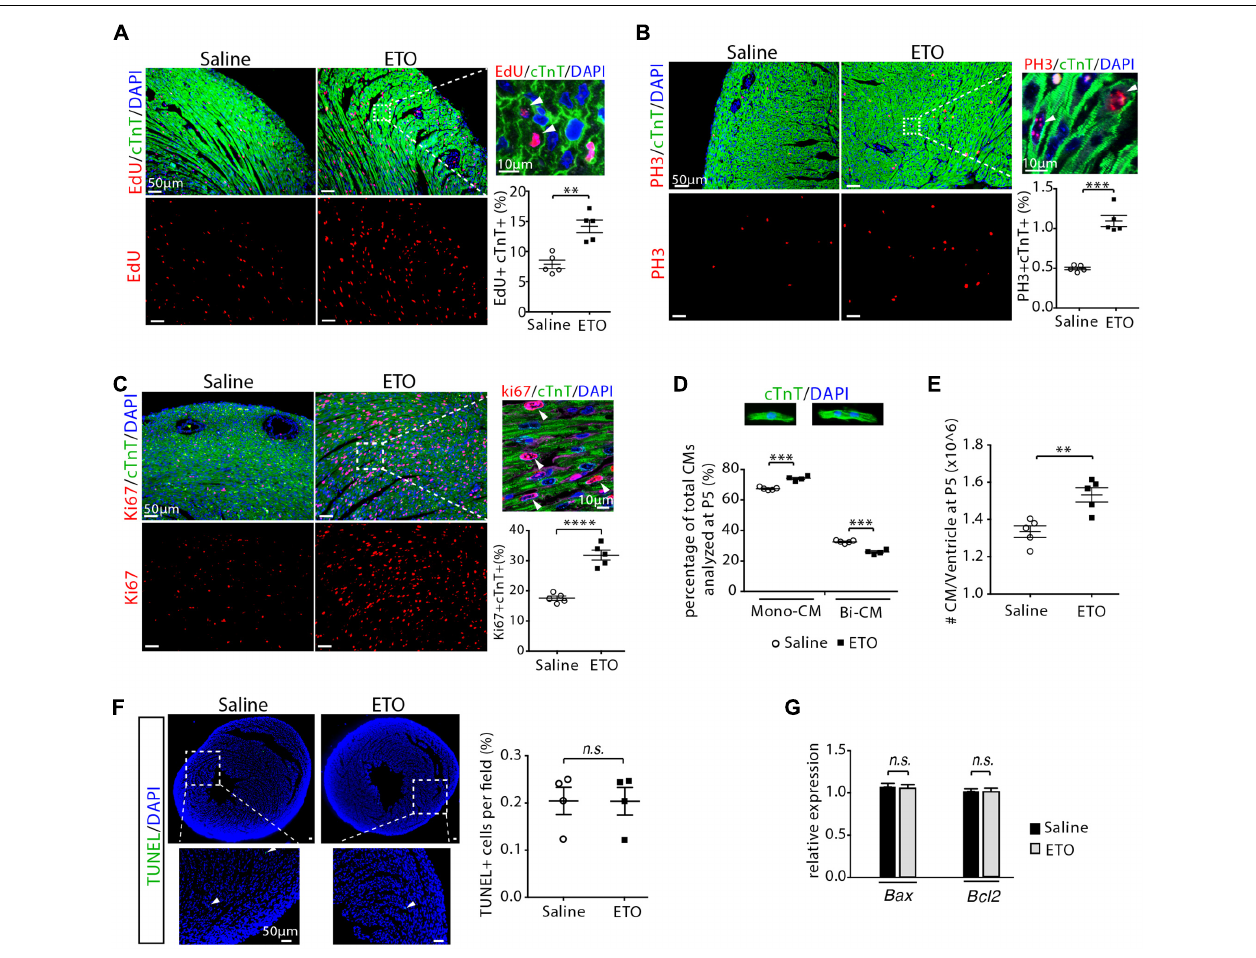
FIGURE 3 | Cardiomyocyte proliferation with etomoxir (ETO) treatment. (A) Cardiomyocytes in DNA synthesis-phase were detected by using Click-iT EdU Alexa Fluor (red) and co-immunostaining with antibody against cTnT (green) on tissue cross sections. Quantification of EdU+cTnT+ cells as percentage of total cTnT+ cells analyzed per field. Arrows point to EdU+cTnT+ cells. (B) Cardiomyocytes in mitotic phase were detected and quantified by immunostaining for PH3 (red) and cTnT (green) on tissue longitudinal sections. Arrows point to PH3+cTnT+ cells. (C) Cardiomyocyte proliferation were visualized by co-immunostaining of heart sections (P5) for Ki67 (red) and cTnT (green). Graph on the right showing quantification of Ki67+cTnT+ as percentage of total cTnT+ cells analyzed per field. Arrows point to Ki67+cTnT+ cells. (D) Percentage of mononuclear (Mono-CM) and binuclear (Bi-CM) cardiomyocytes in the heart ventricles of infant mice at P5. (E) Total number of cardiomyocytes in heart ventricles in infant mice at P5. (F) Immunostaining and quantification of TUNEL (green) and DAPI (blue) in P5 heart sections. Arrows point to TUNEL+ nuclei. (G) Expression of Bax and Bcl2 by qRT-PCR analysis of the mRNA of isolated heart ventricles at P5 ( n = 4 per group). P value was calculated